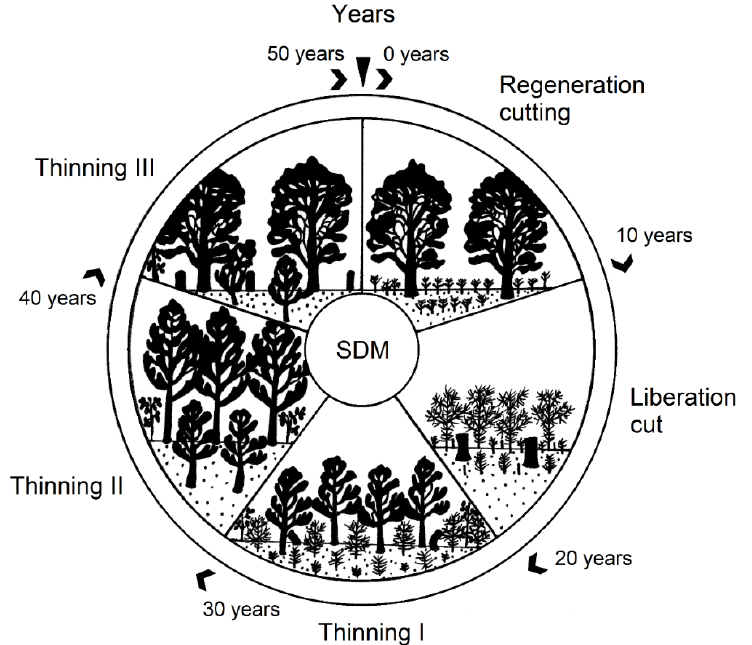
Figure 2. Silvicultural Development Method (SDM) cycle scheme, with a rotation period of 50 years. The age intervals indicate the opportune period for application of each treatment, counting from the beginning of the rotation. Regeneration cutting promotes the establishment of a new cohort of trees, in which most of the adult trees are removed, but some of the best individuals are left as seed trees. Liberation cut (LC) involves intermediate cuts that attempt to release the natural regeneration of the Pinus species. Thinning (TH) involves intermediate cuts in three stages, applied to control the stand density to favor the growth of exploitable individuals. Modified from [21].